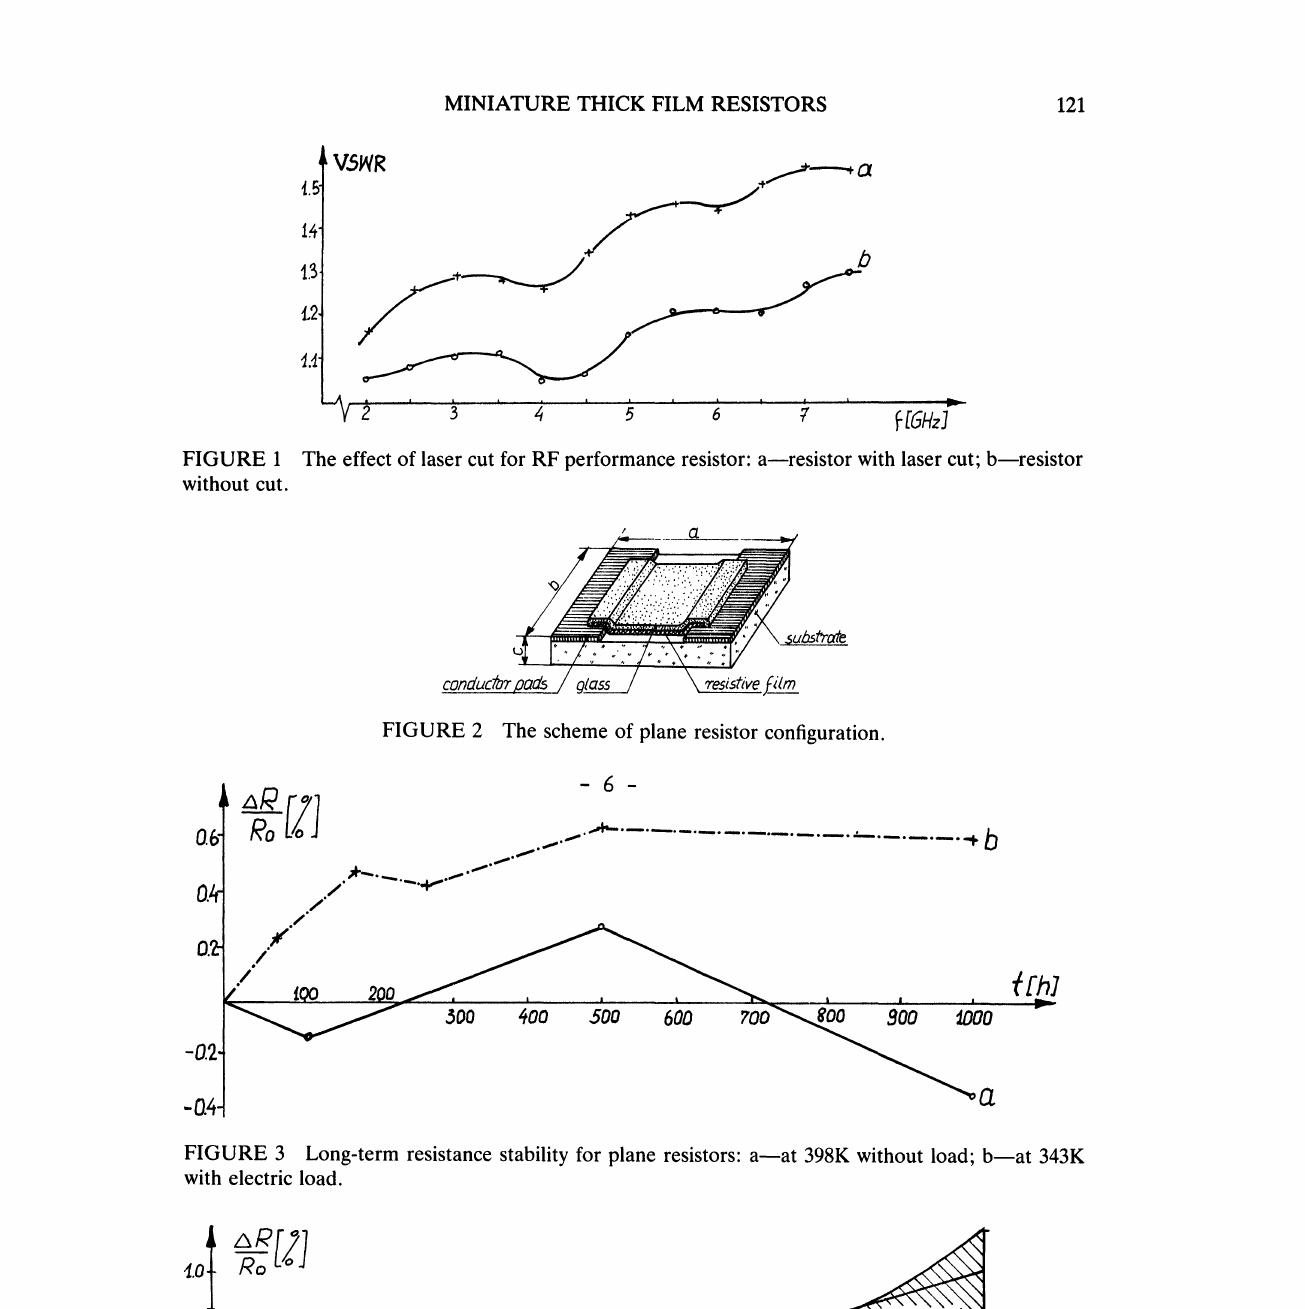
FIGURE 3 Long-term resistance stability for plane resistors: a--at 398K without load; bmat 343K with electric load.